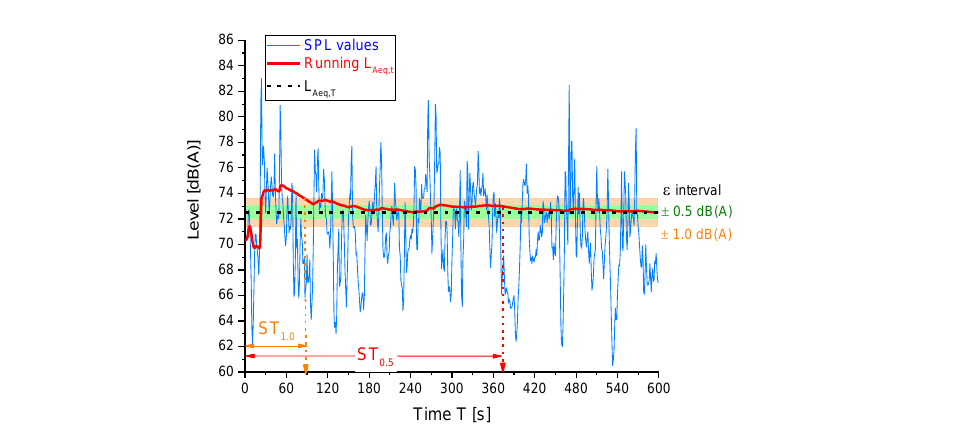
Figure 1. Concept of stabilization time ST of the continuous equivalent level L Aeq,t and two preset uncertainty intervals ε set for the L Aeq,T estimate. The green band corresponds to ε = ±0.5 dB(A) and the orange one to ε = ±1.0 dB(A). The blue and red lines represent the sequence of SPL values and the running L Aeq,t , respectively, whilst the horizontal dashed black line corresponds to the L Aeq,T level.